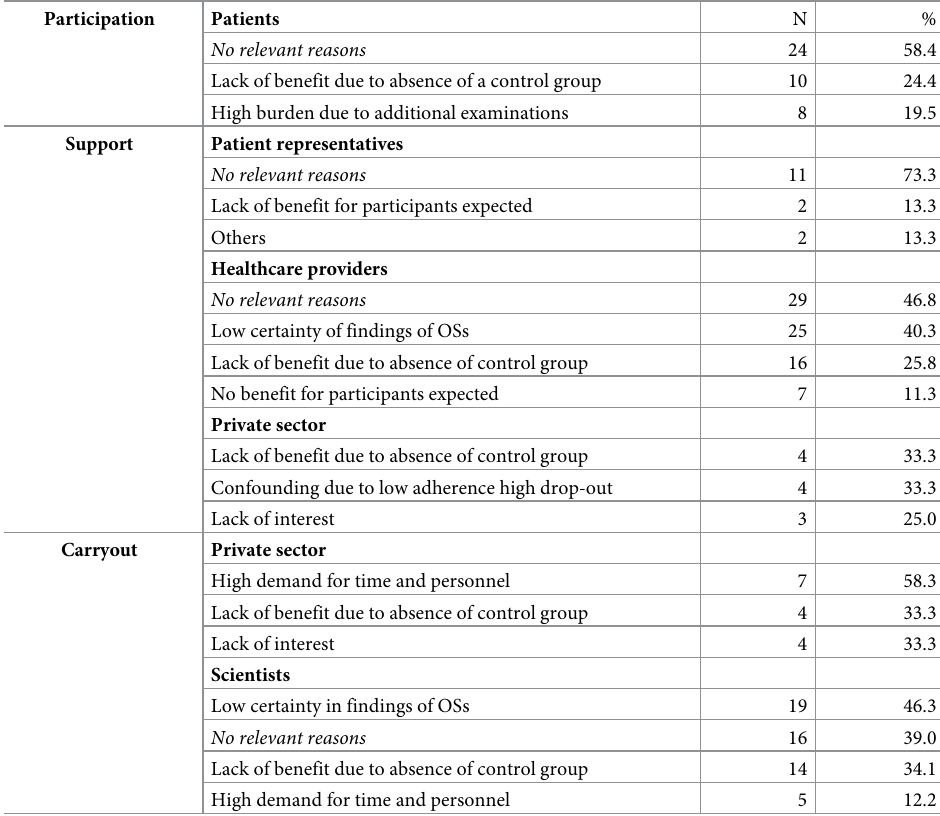
Table 6. Motives against engaging in observational